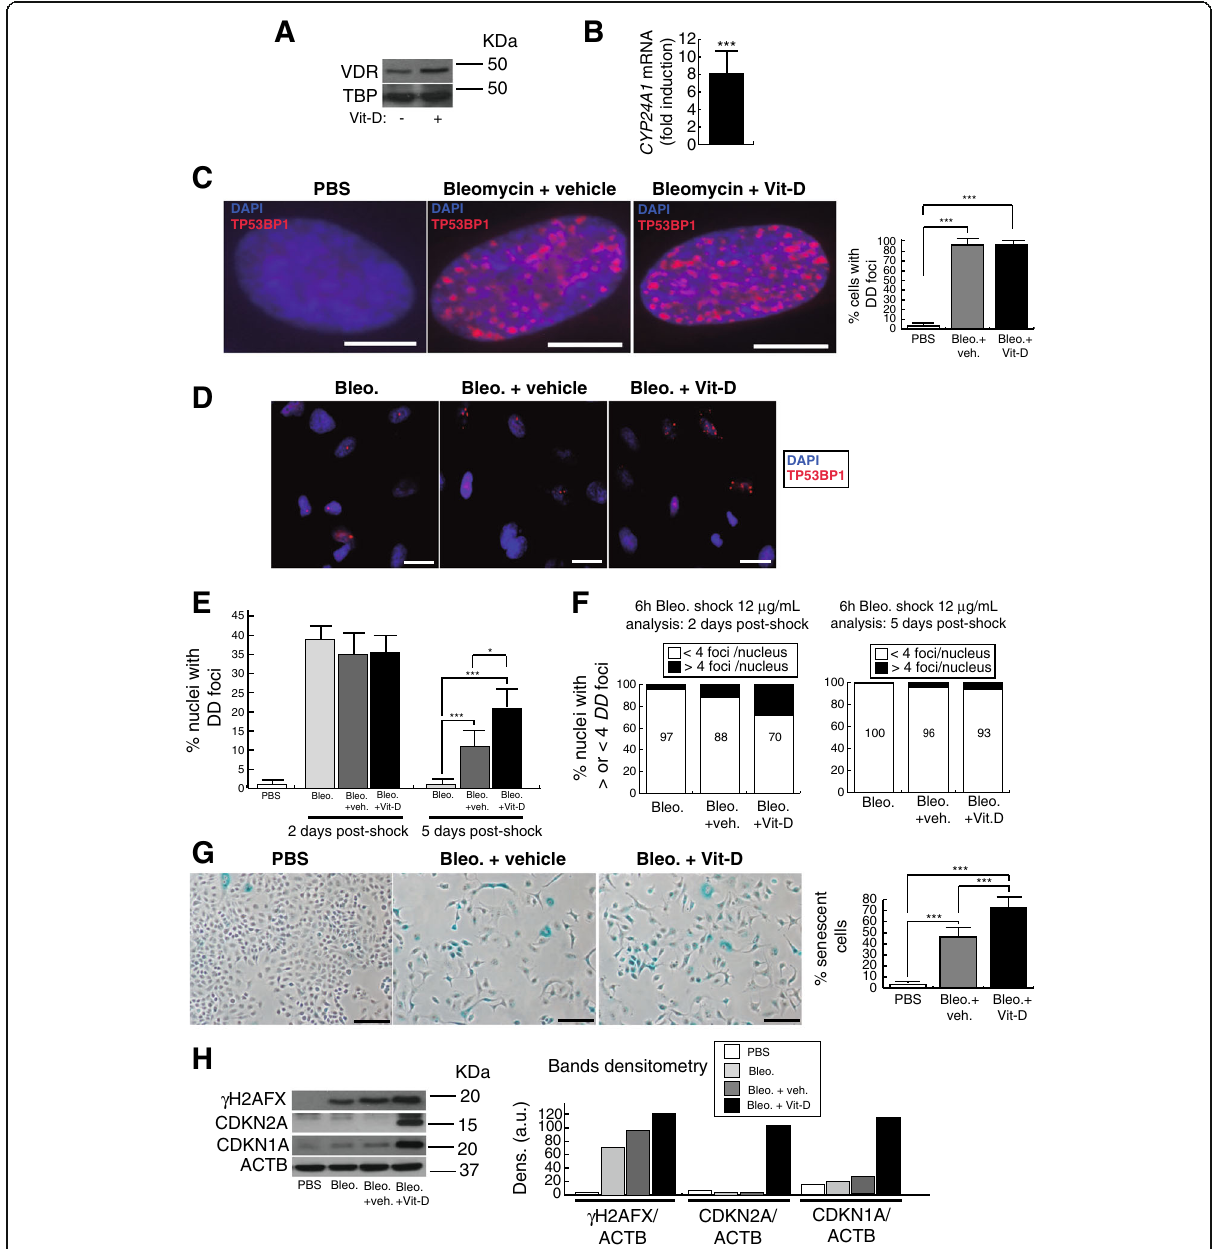
Fig. 1 Effects of vitamin D and bleomycin in A549 cells. a Detection of vitamin D receptor (VDR) in A549 cell extracts. Cells were treated or not with 5 nmol/L vitamin D for 48 h. TBP (Tata box binding protein was used as loading control. KDa: kilodaltons. b RT-qPCR result: expression of CYP24A1 in A549 cells treated for 48 h with 5 nmol/L vitamin D. Values are relative to A549 cells treated with vehicle. c Expression of DSBs induced by bleomycin. Representative micrographs of A549 nuclei harboring DNA damage foci containing TP53BP1, a marker of DSBs, are shown. Right panel: quantification of damaged cells. Scale bar: 5 μ m. d Expression of TP53BP1 foci (red dots) in cultures of A549 cells pretreated with 5 nmol/L vitamin D for 2 h, subjected to a bleomycin shock (12 μ g/mL for 6 h) and then treated with 5 nmol/L vitamin D or its vehicle. Representative micrographs taken at 48 h post-shock are shown. Scale bar: 20 μ m. e Quantification of damaged cells (nuclei with TP53BP1 foci) at two and five days after bleomycin shock (12 μ g/mL for 6 h). f Quantification of DD foci per nucleus at two and five days after bleomycin shock (12 μ g/mL for 6 h). g Senescence-associated β -galactosidase assay (SA- β gal). Representative micrographs of A549 cultures at 48 h post-treatments are shown. Scale bar: 100 μ m. Quantification of senescent cells is shown in the right panel. h Detection of γ H2AFX, CDKN2A and CDKN1A in A549 cell extracts. Cells were pretreated with 5 nmol/L vitamin D for 2 h, subjected to a bleomycin shock (12 μ g/mL for 6 h) and then treated with 5 nmol/L vitamin D or its vehicle. Cell extracts were obtained at 48 h post-shock. Control cultures were cells treated with bleomycin vehicle (PBS). ACTB was used as loading control. KDa: kilodaltons. Right panel: densitometry analysis of bands; a.u: arbitrary